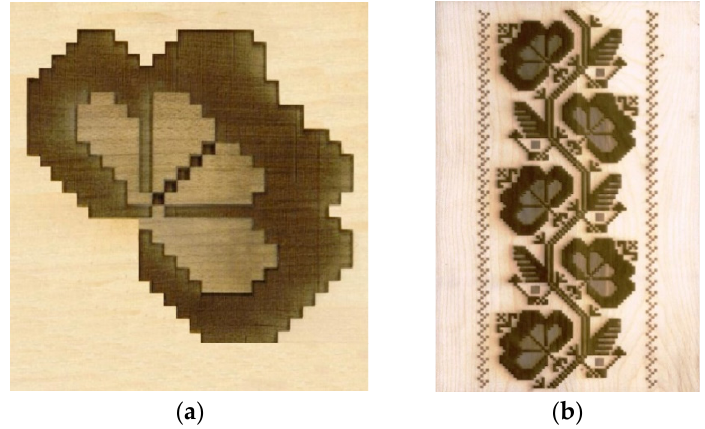
Figure 10. Laser engraved model using 40% of maximum power of the equipment for burgundy and 10% of maximum power of the equipment for beige: ( a ) The selected detail; ( b ) The complete traditional motif.